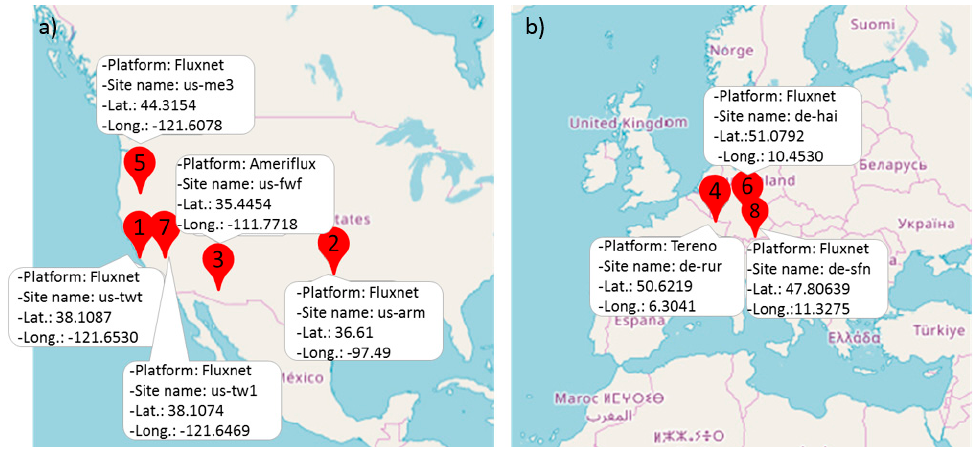
Figure 1. Location, Platform and identification number of the eddy covariance (EC) stations under investigation in ( a ) U.S.A. and ( b ) Europe.